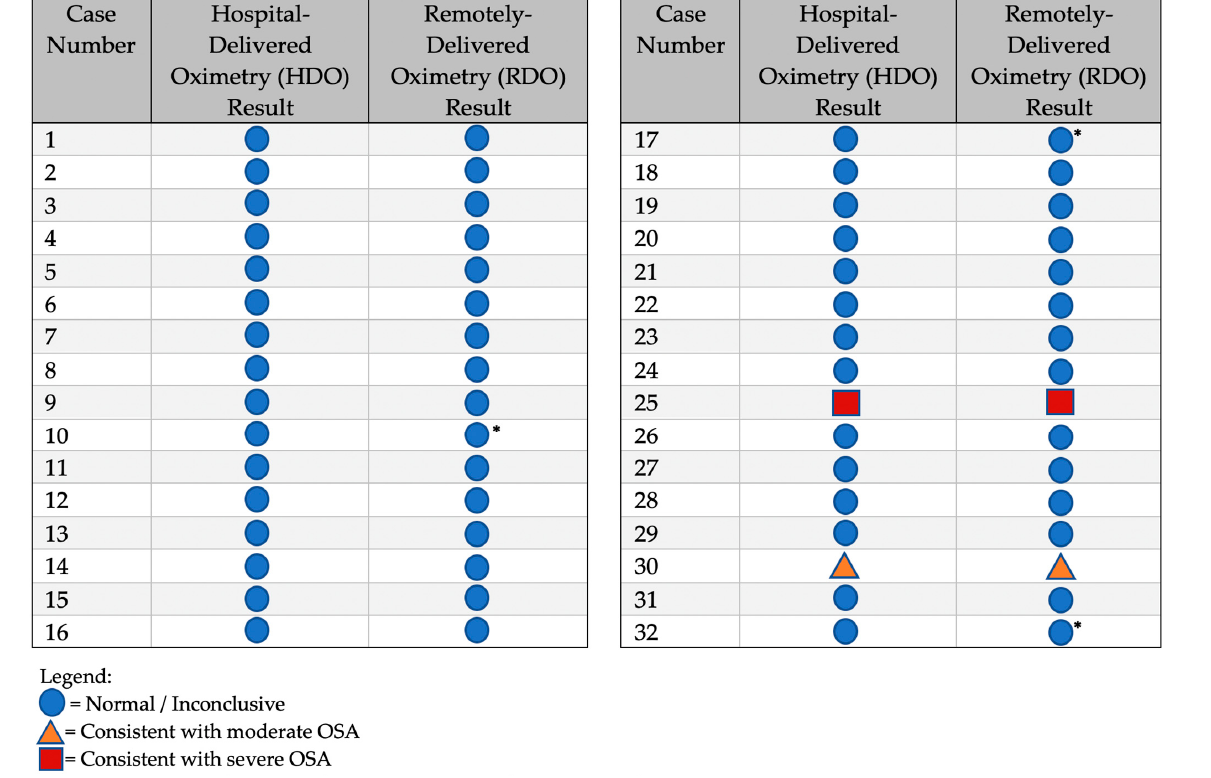
Figure 3. Clinical Result Comparison: The table compares the hospital-delivered oximetry (HDO) results to the remotely delivered oximetry (RDO) results. The 3 possible outcomes are shown alongside the corresponding result for the other test. Known tests that required a repeat are denoted with an asterisk. The repeat rate for city-based oximetry was unknown. ∗ = Known required repeats of RDO. Repeat rate of HDO was unknown.